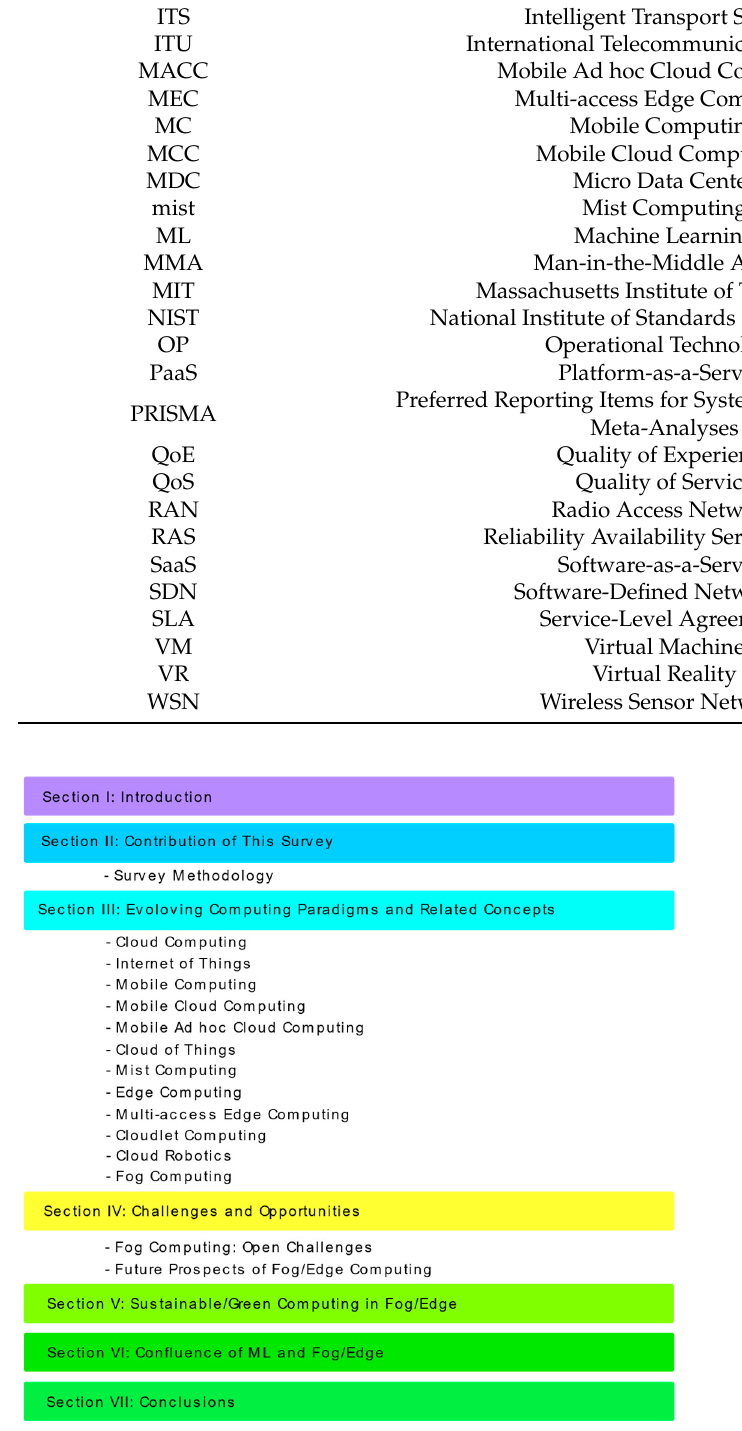
Figure 1. Organization of this survey paper.